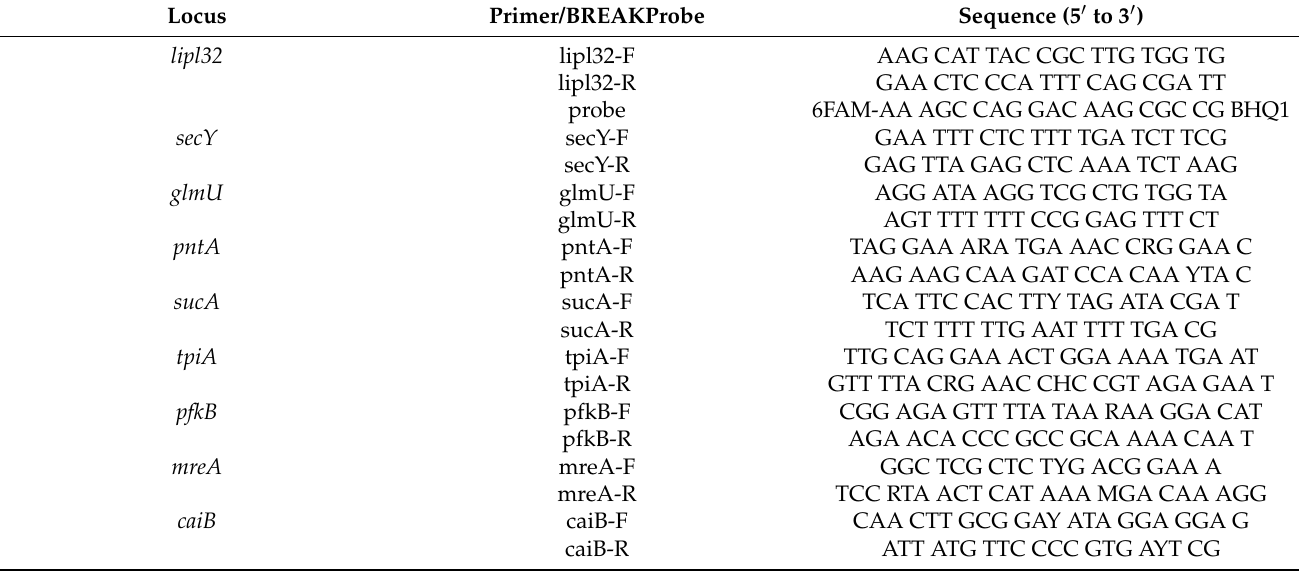
Table A2. Gene loci, primer sequences and probe used for qPCR [62], SLST [63] and MLST